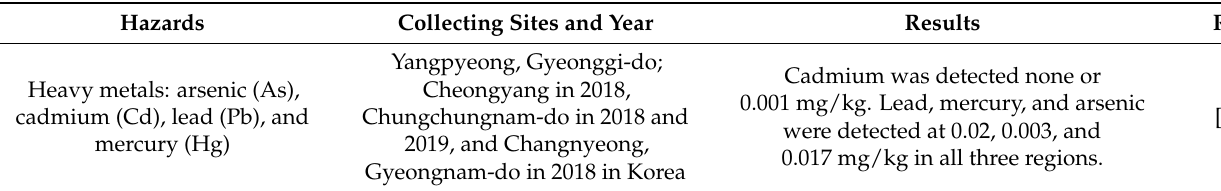
Table 2. Safety of honeybee ( Apis mellifera L.) drone